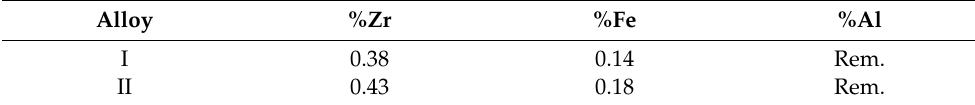
Table 1. Chemical composition (in weight